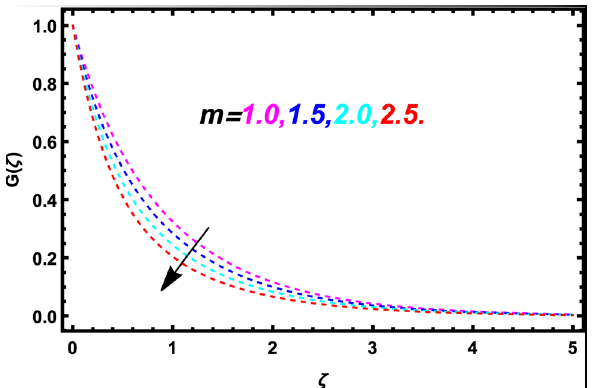
Figure 14. Demonstration of velocity curve versus m when Fr = 0.2, k 1 = 0.1, k 2 = 0.3, M = 0.5, Pr = 5.3, φ = 0.01, Ec = 0.3, ε Rd = 0.2, Sc = 0.1, ε Lb = 0.3, Pe = 0.3. t = 3.0, C = 3.0, δ = 0.3,